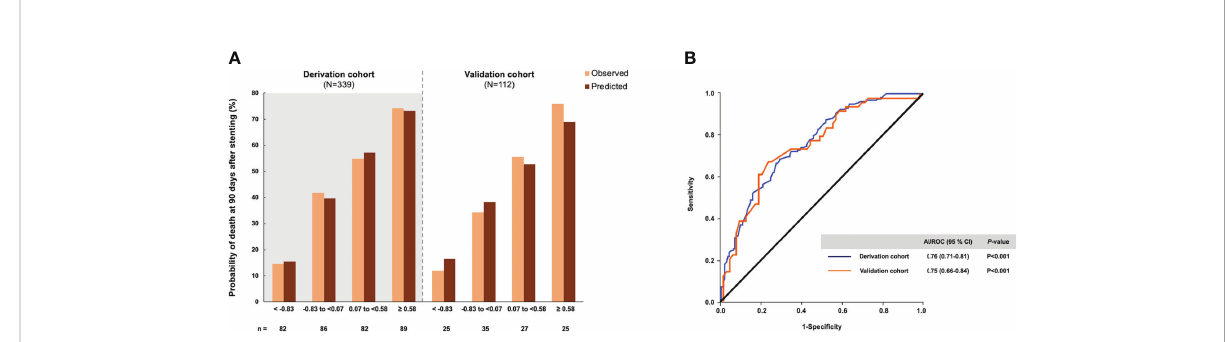
FIGURE 1 The probability of death within 90 days after endobiliary stent placement and diagnostic accuracy of the risk score in the derivation and validation cohorts. (A) The observed and predicted mortality rates according to the approximate quartiles of the risk score. (B) Area under the receiver operating characteristic curve of the risk